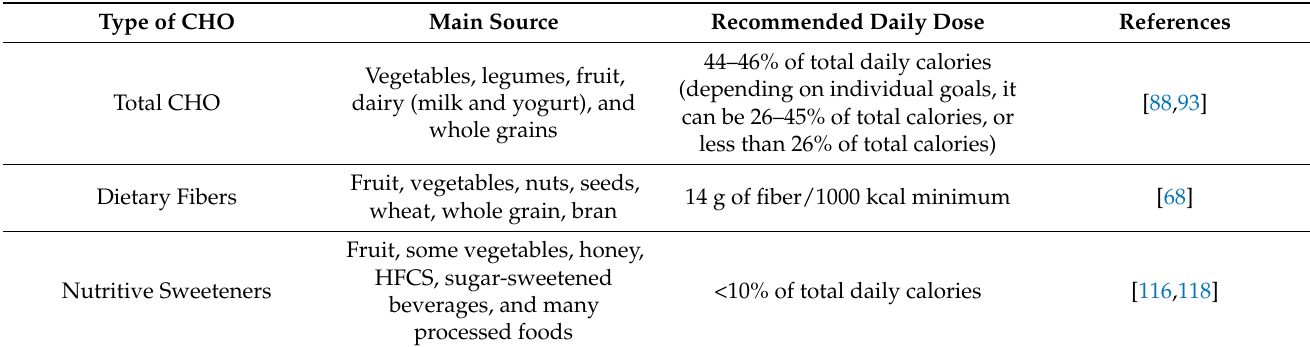
Table 1. Recommended CHO distribution for patients with